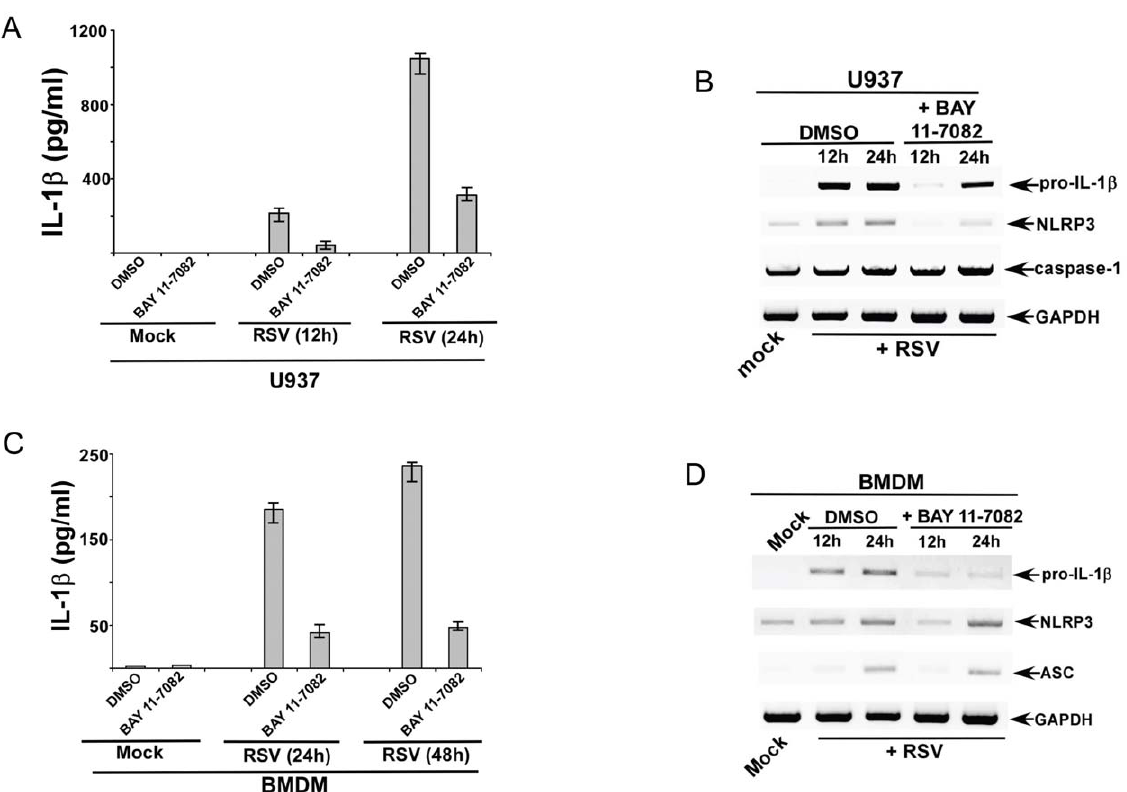
Figure 5. NF- k B signaling is critical for IL-1 b secretion during RSV infection. ( A ) Human U937 cells were infected with RSV (1 MOI) in the presence of either DMSO (control) or NF- k B inhibitor (BAY 11-7082). IL-1 b levels in the medium supernatant were assayed by ELISA at 12 h and 24 h post-infection. ( B ) RT-PCR analysis of pro-IL-1 b , caspase-1 and NLRP3 expression in U937 cells infected with RSV in the presence of either DMSO (control) or BAY 11-7082. ( C ) Wild type primary mouse bone marrow derived macrophages (BMDM) were infected with RSV (1 MOI) in the presence of either DMSO (control) or BAY 11-7082. IL-1 b levels in the medium supernatant were assayed by ELISA at 12 h and 24 h post-infection. ( D ) RT-PCR analysis of pro-IL-1 b , ASC and NLRP3 expression in WT BMDMs infected with RSV in the presence of either DMSO (control) or BAY 11-7082. The gels shown in (B) and (D) are representative of three independent experiments that yielded similar results. For ELISA results, each value represents the mean 6 standard deviation from three independent